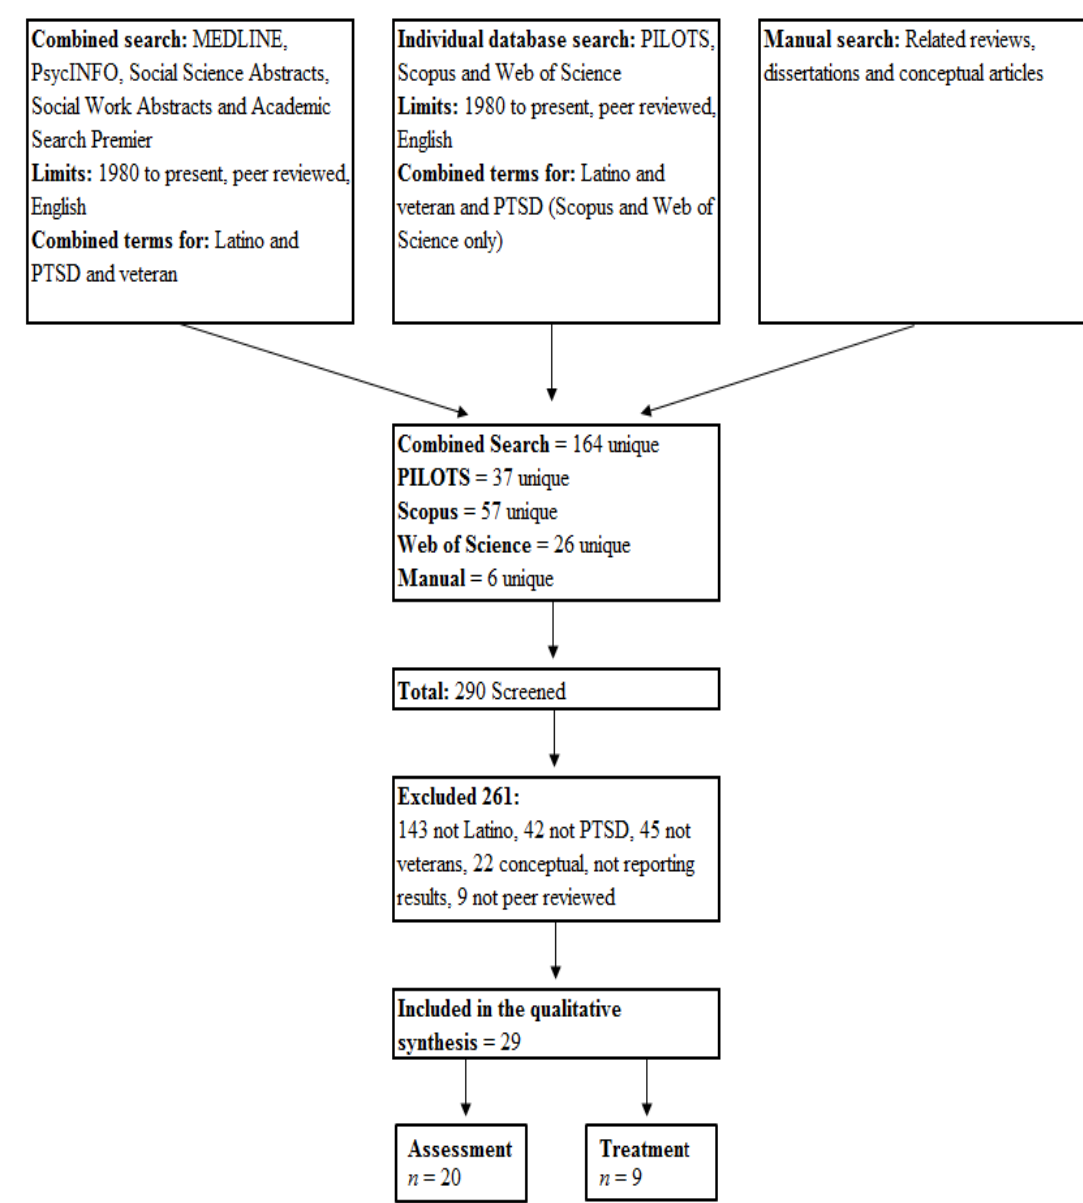
Figure 1. Flow diagram of article